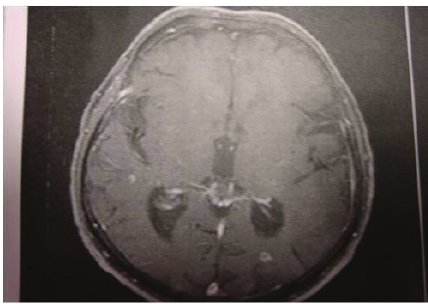
Figure 3: Axial MRI of the brain following 3 months of anti-TB therapydemonstratinganimportantresolutionofthepreviousbrain lesions.